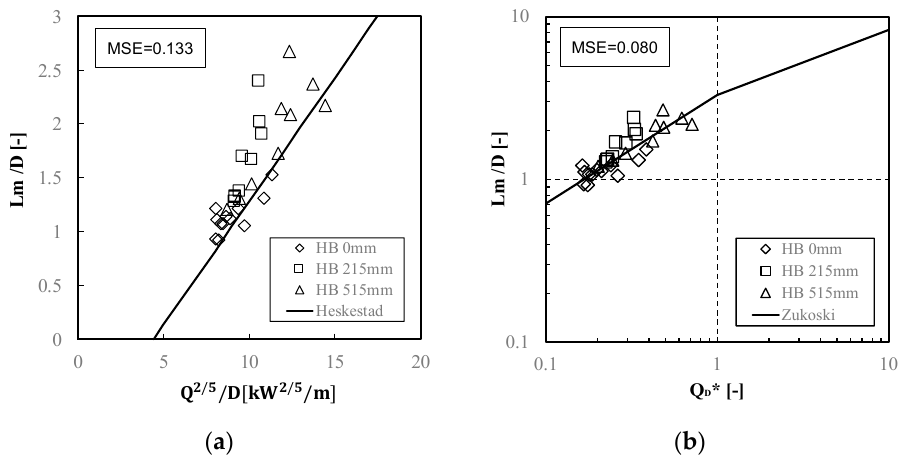
Figure 10. Comparisons of experimental data and two major equation models in the average flame height. ( a ) Heskestad’s formula (Equation (2)). ( b ) Zukoski’s formula (Equation (3)).